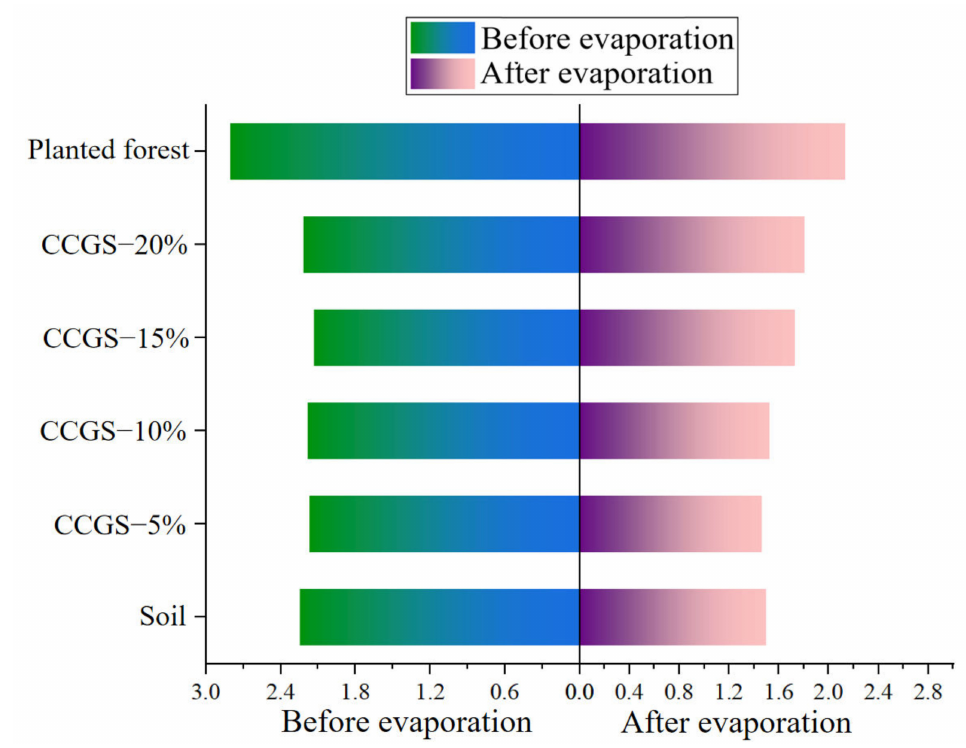
Figure 22. Changes of eight